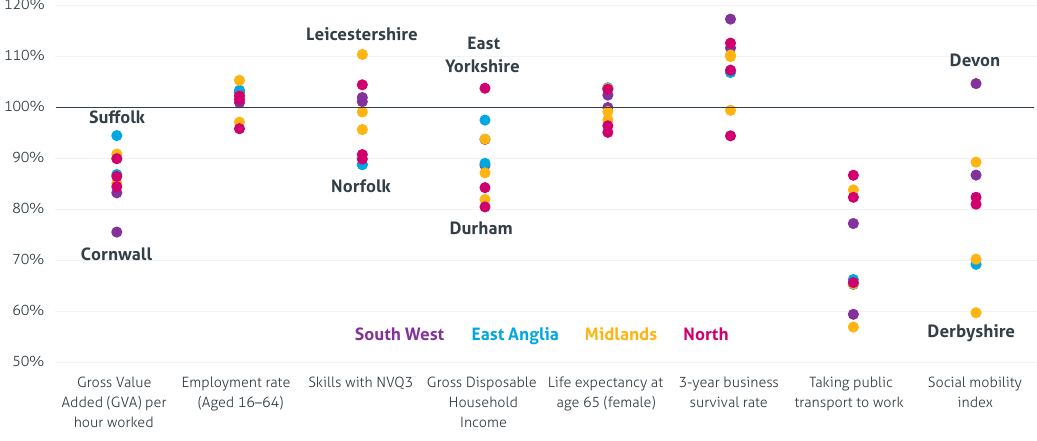
Figure 6 Comparison of proposed local devolution areas identified in the levelling up white